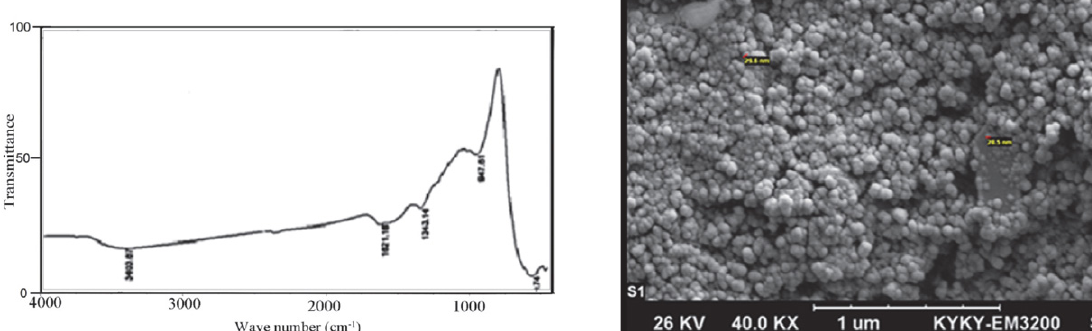
Figure 2. FT-IR spectra of MnFe 2 O 4 nanoparticles.